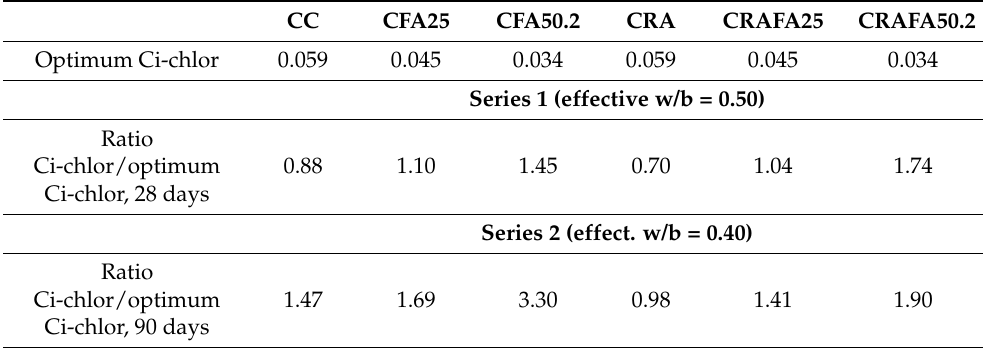
Table 7. The optimum Ci-chlor values of each concrete and the ratios of the obtained results with respect to the optimum